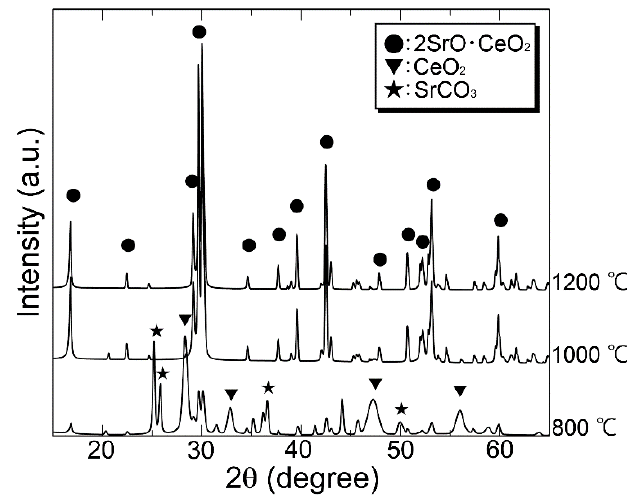
Figure 1. XRD pattern of S 2 Ce powders calcined at various temperatures.